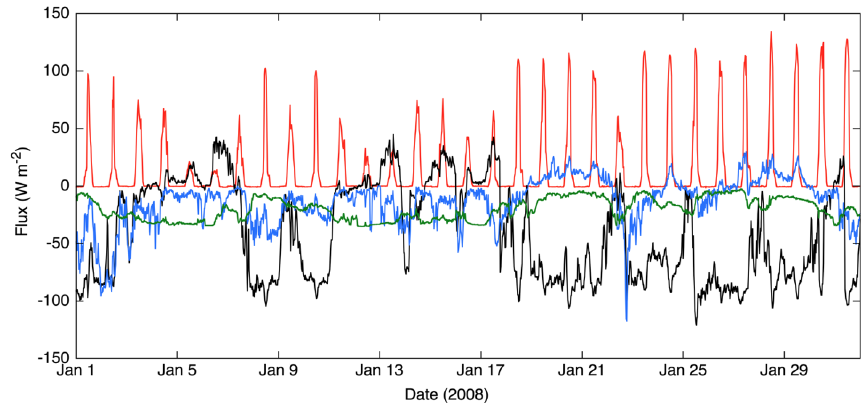
Figure 2. Energy balance components as measured by the AWS on the Vadret da Morteratsch for January 2008. Net solar radiation in red, net longwave radiation flux in black, turbulent sensible heat flux in blue, turbulent latent heat flux in